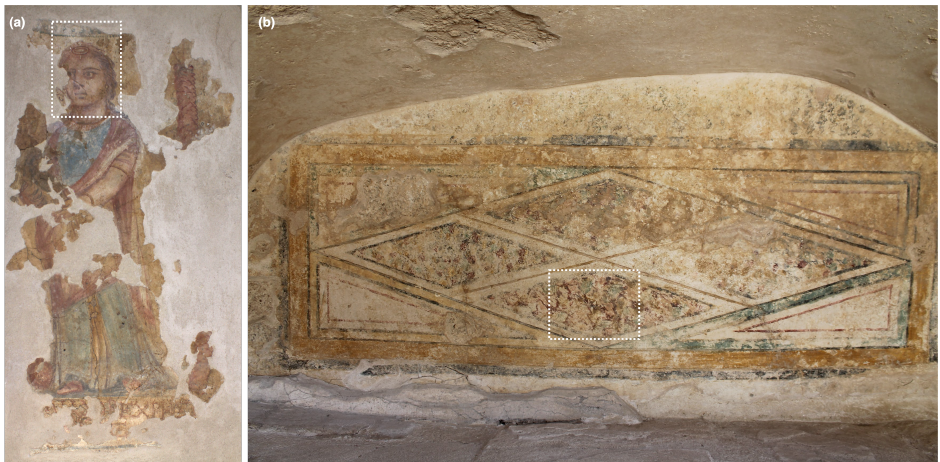
Figure 3. ( a ) Painting of a woman , from Tomb 3510 (Case Study 1). ( b ) Tympanum painting Imitation marble on the southeast arcosolium of Tomb 3882 (Case Study 2). The scanned areas of each painting are outlined in